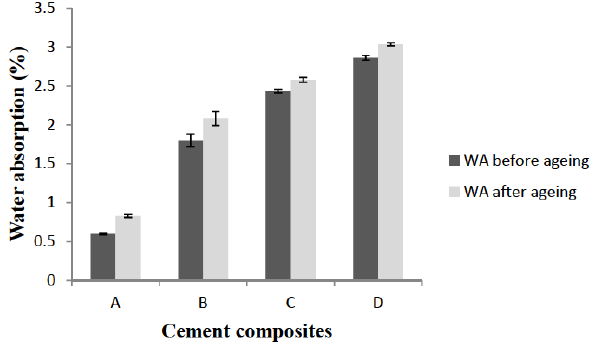
Figure 3: Accelerated ageing effects on water absorption